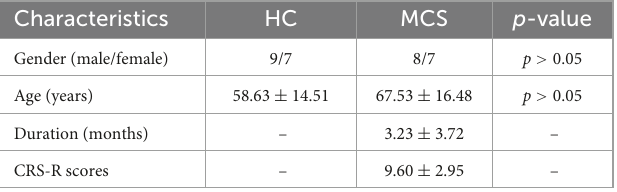
including the left PreM and SMA, left Broca’s area, left FEF, left FPA, left DLPFC, right PreM and SMA, right Broca’s area, right FEF, right FPA, right